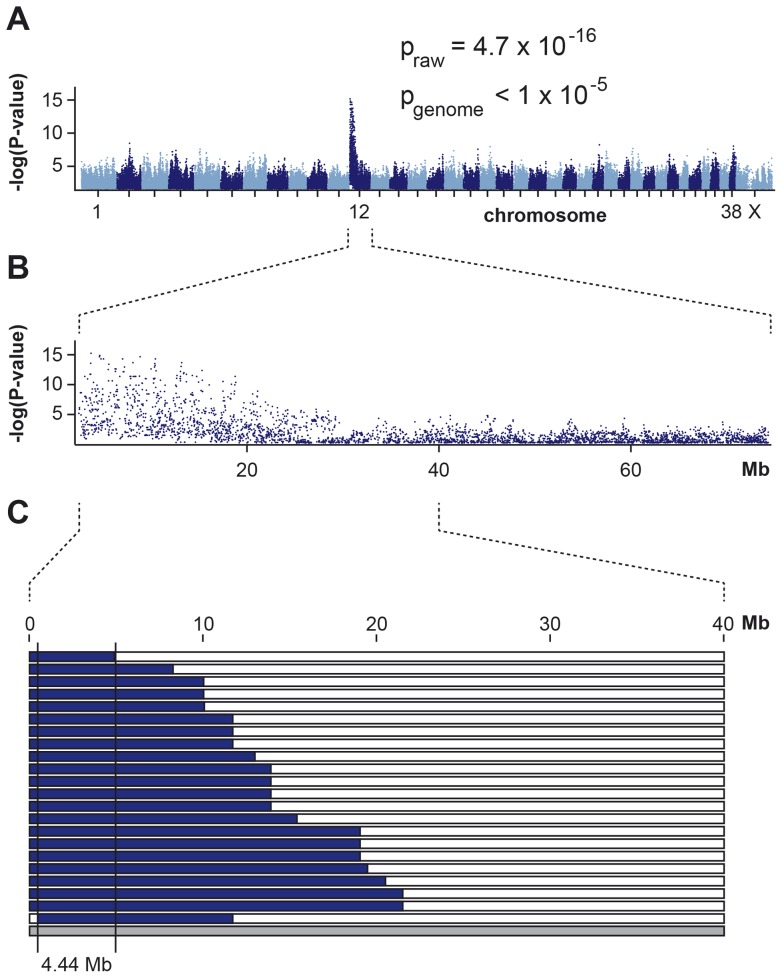
Mapping of SD2 in Labrador Retrievers.(A) A genome-wide association study using 23 cases and 37 controls indicates a strong signal with multiple associated SNPs on CFA 12. (B) The detailed view of CFA 12 delineates an associated interval of ∼18 Mb at the beginning of the chromosome. (C) Homozygosity mapping. Each horizontal bar corresponds to one of the 23 analyzed cases. Homozygous regions with shared alleles are shown in blue. A shared homozygous interval of ∼4 Mb in 22 of the 23 cases delineates the exact boundaries of the critical interval from 467,795 bp to 4,906,914 bp (CanFam 3 assembly). The 23rd case did not carry the associated haplotype and was also phenotypically slightly distinct from the other 22 cases (Figure S1).